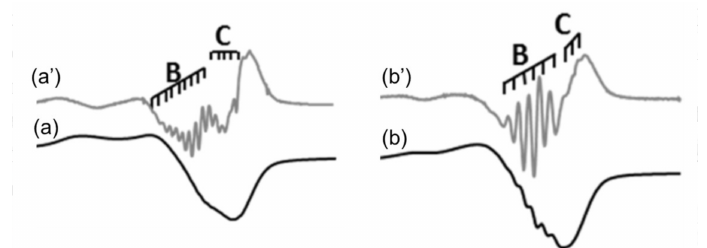
Figure 8. EPR spectra recorded at 25 ◦ C after the adsorption of 6 NH 3 /Cu atom ( a ) or 6 15 NH 3 per Cu ( b ) on Cu-SSZ-13 followed by degassing at 25 ◦ C. ( a (cid:48) and b (cid:48) ) are second derivatives of the spectra, used to determine the super-hyperfine structure of EPR signals B and C. Reprinted with permission